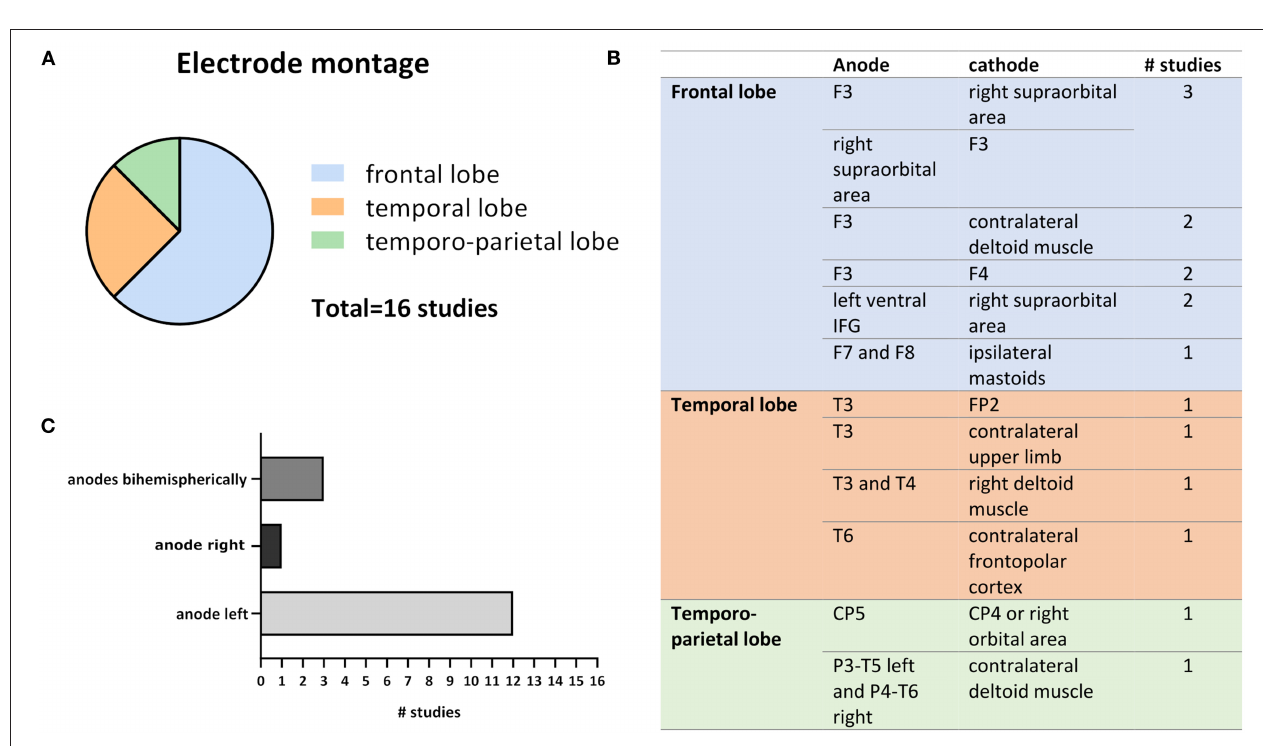
FIGURE 3 | Variations in electrode montages extracted from the 16 reviewed studies. (A) Shows the relative numbers of studies out of all 16 studies that chose frontal, temporal or temporo-parietal cortical targets for tDSC. (B) Depicts exact anode and cathode positions as well as the number of studies that applied respective montage. (C) Compares the frequency of anodal left, right, and bihemispheric cortical stimulation (the anode is usually considered as the active